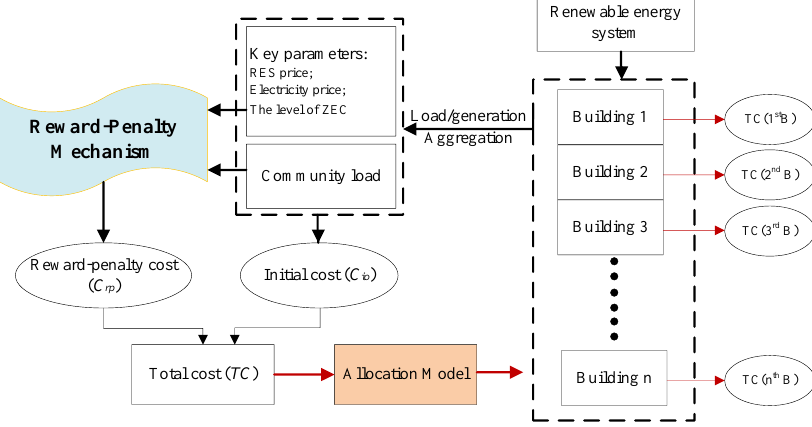
Fig. 1. Schematic diagram of allocation model for community-based